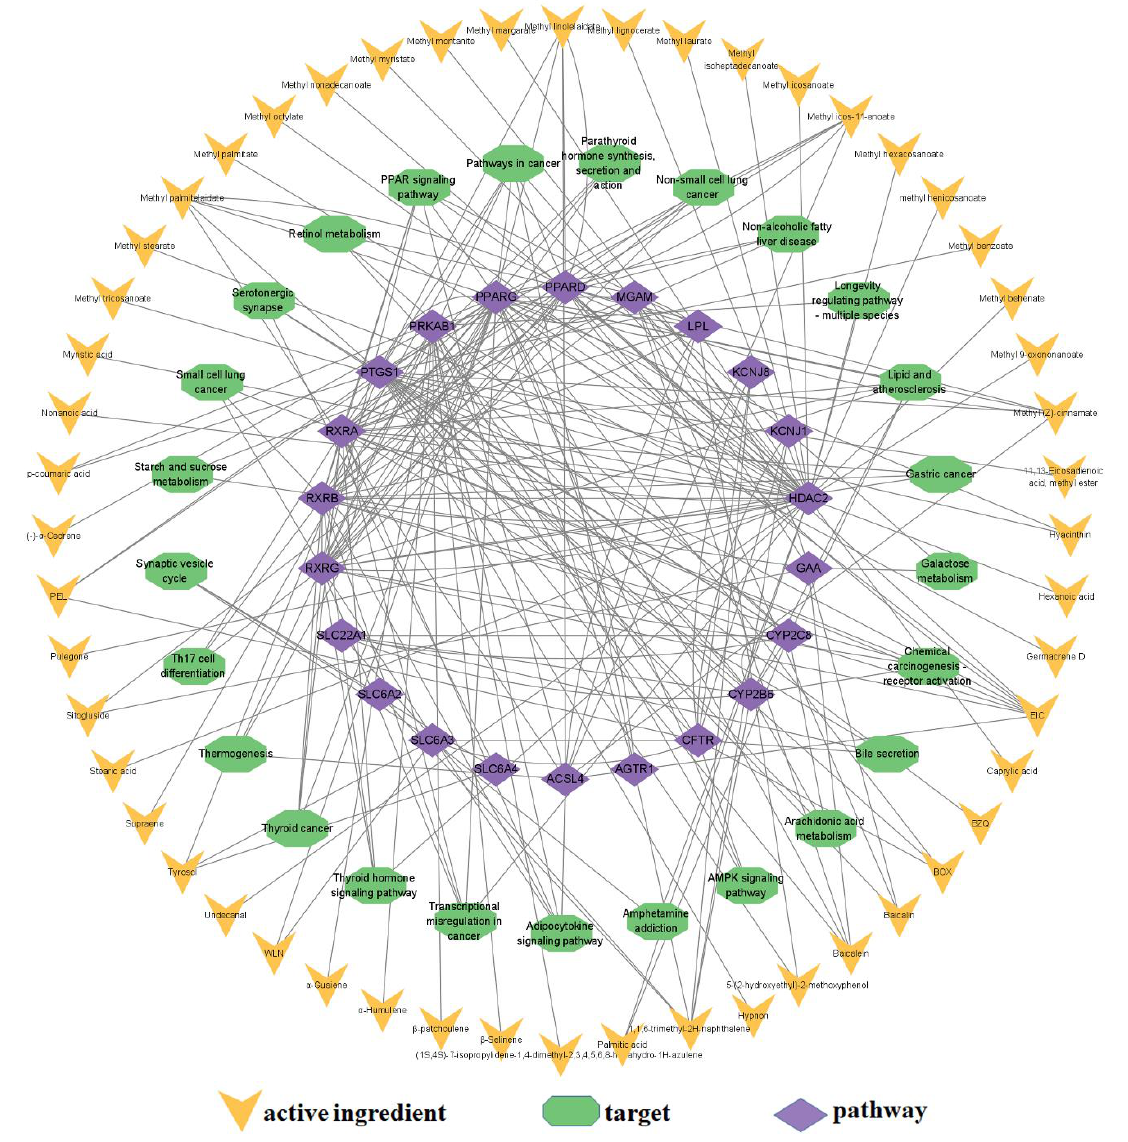
Figure 4. The interaction network of ingredient, target and pathway. The nodes represent the ingredients (orange arrows), the targets (green octagons) and the pathways (purple diamonds), and the edges represent the interactive relationships between two nodes.